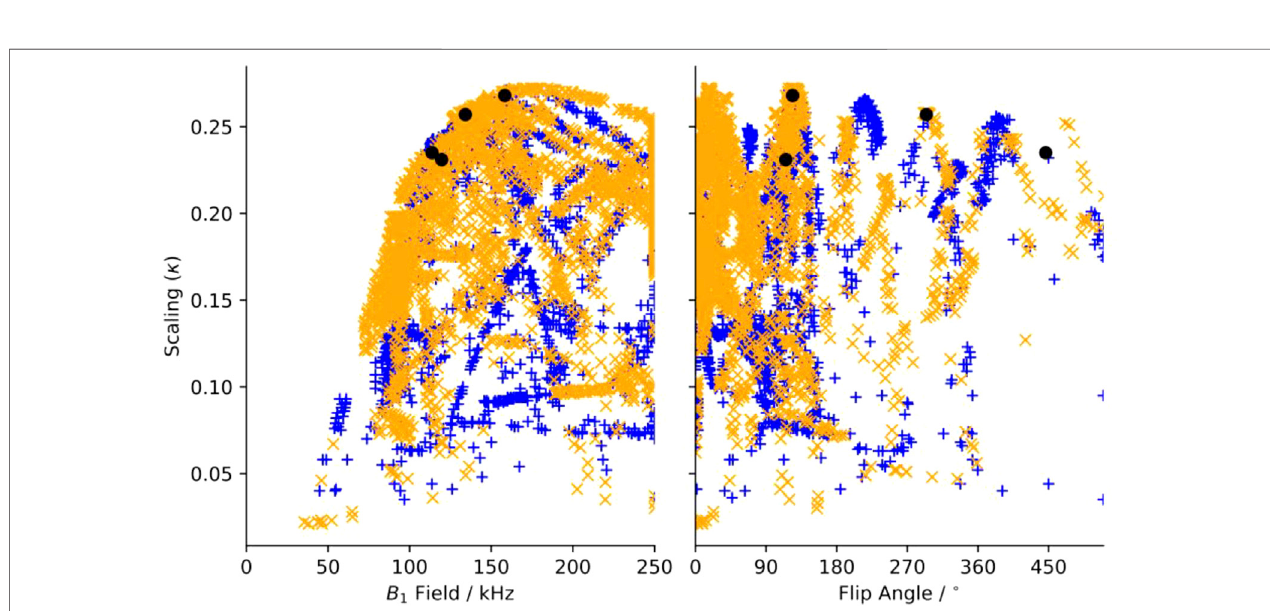
FIGURE 2 | Dipole-dipole recoupling spectra of the R22 219 symmetry as a function of ν 1 match condition for different variable fl ip angle pulse sequence elements.